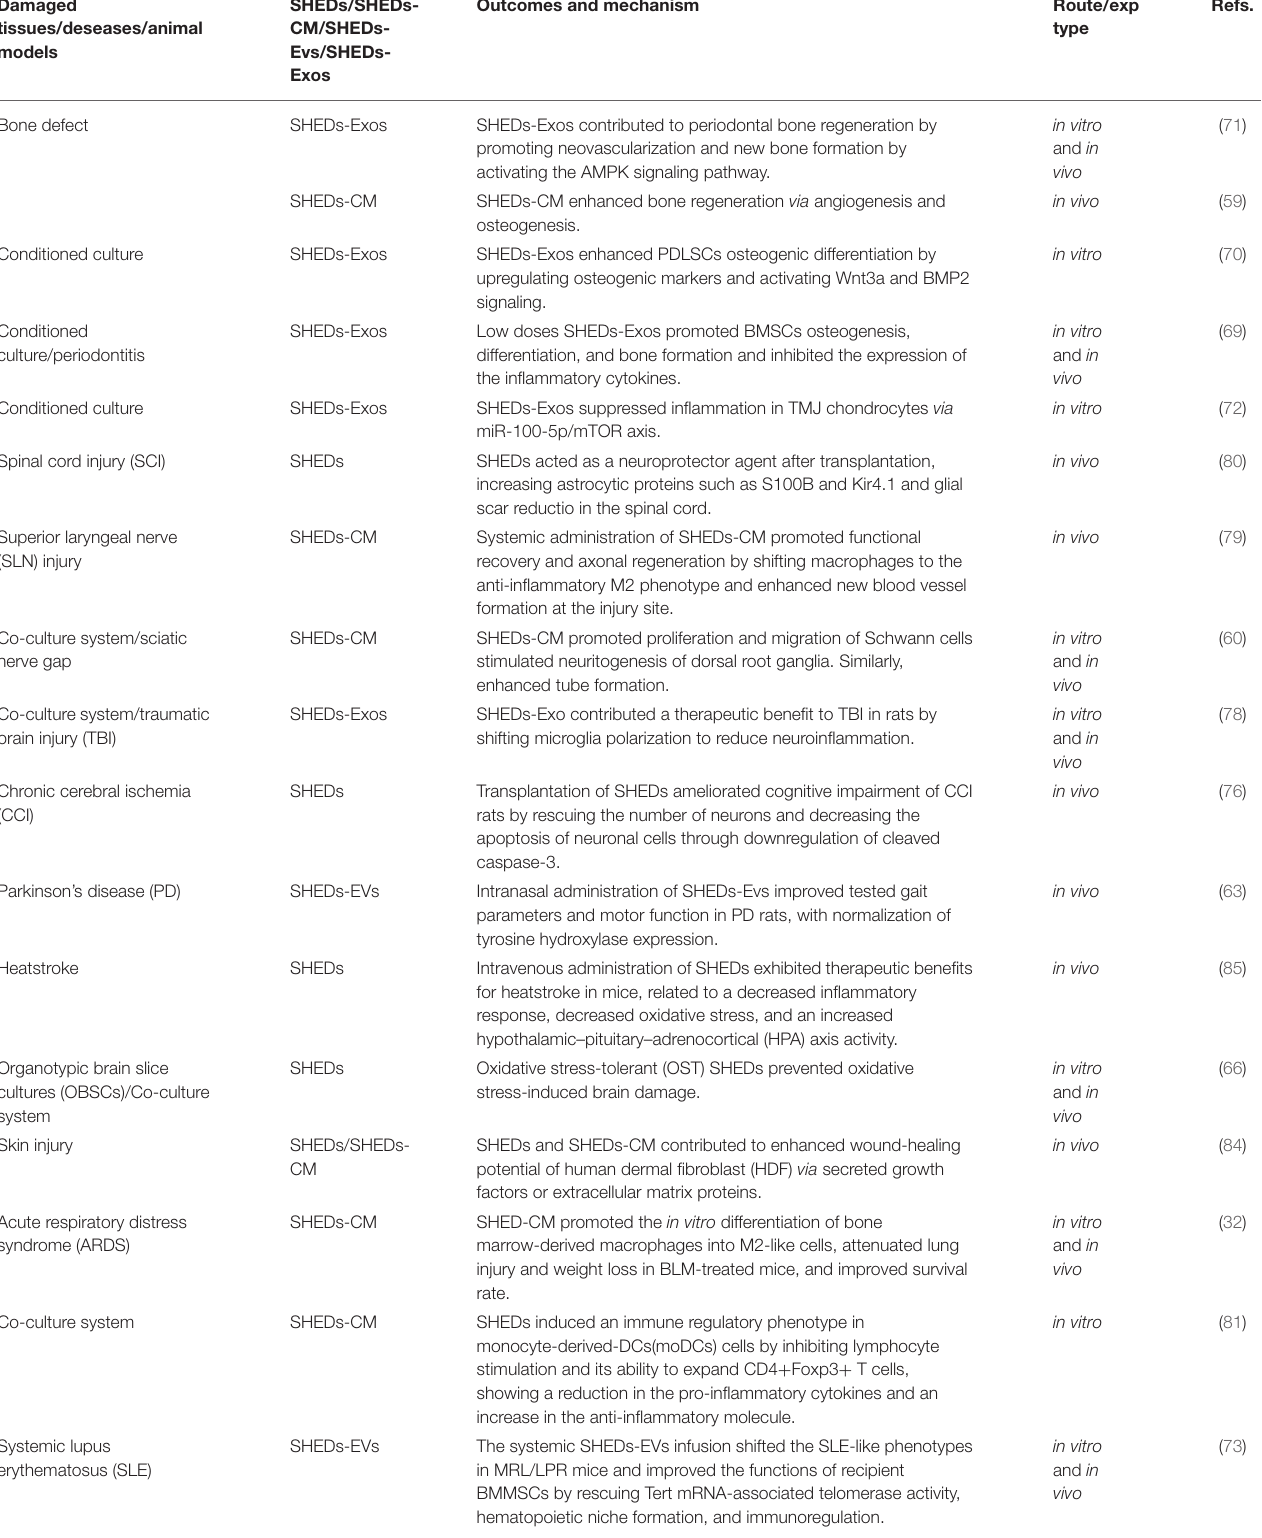
TABLE 2 | Therapeutic potential of SHEDs via paracrine activity and